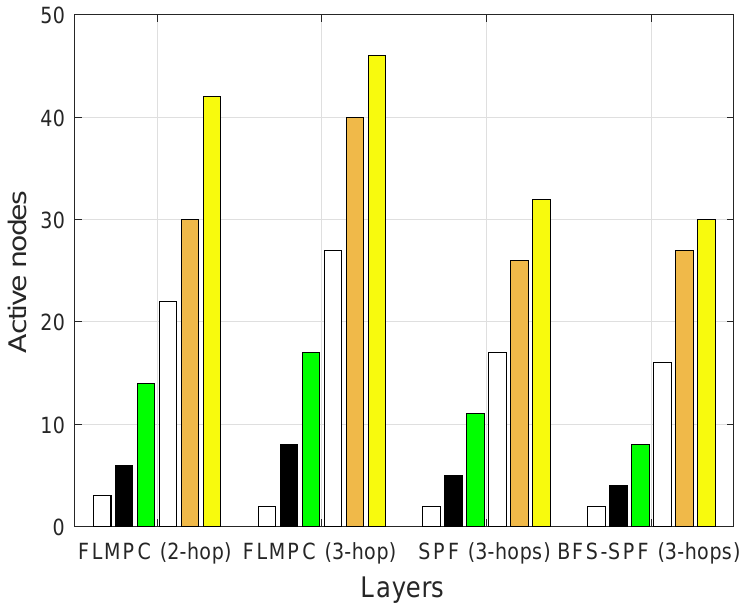
Figure 9. Number of Active Nodes per